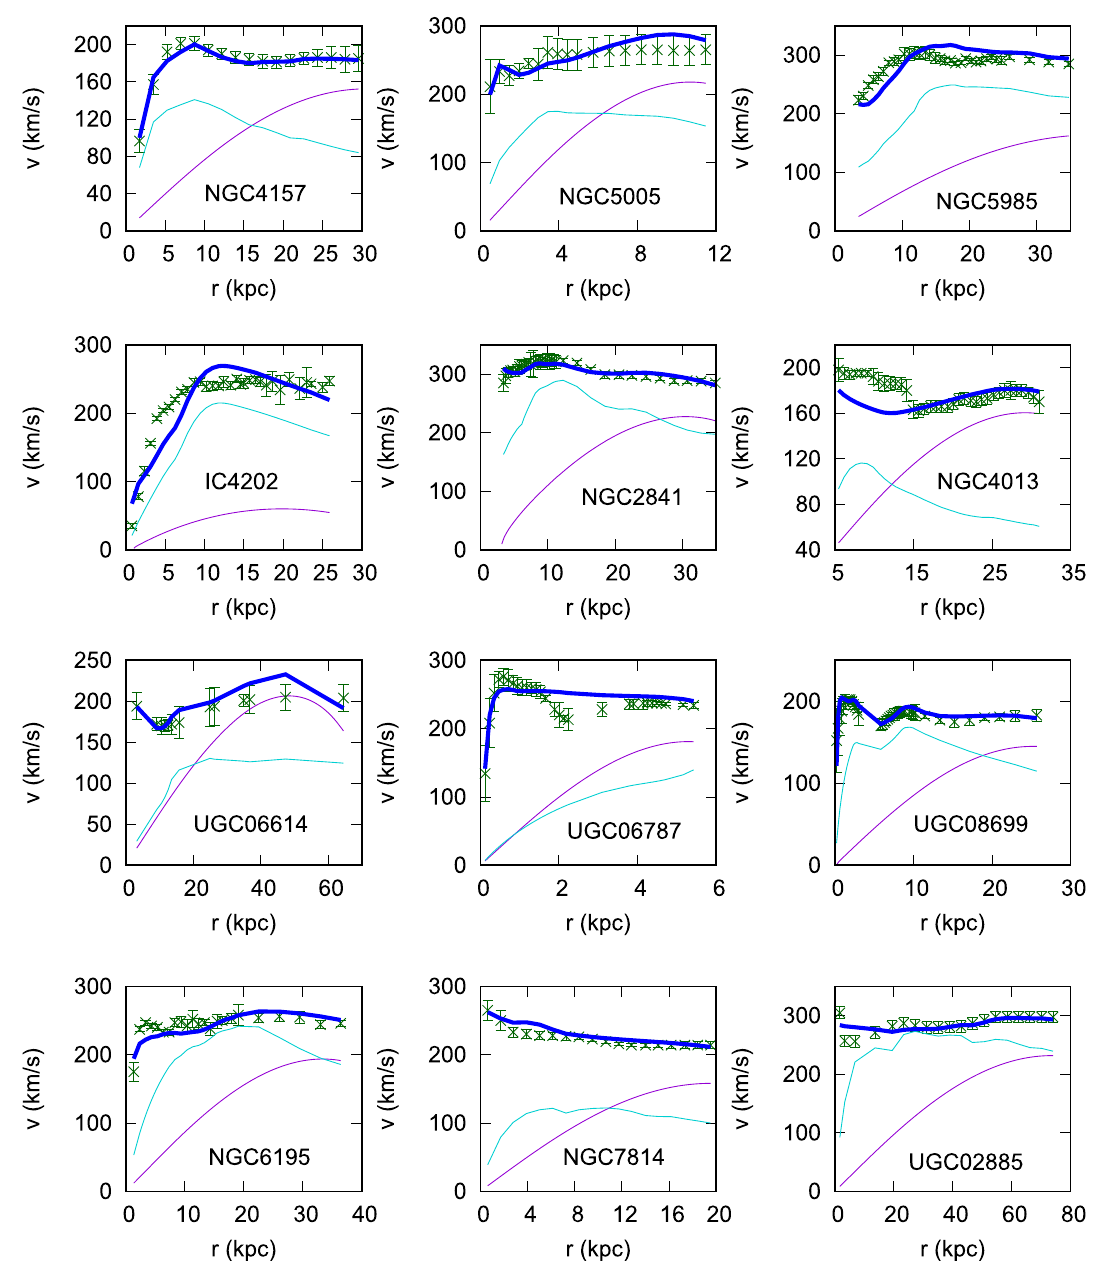
Fig. 6 Comparison of the theoretical predictions for the galactic rotation of the random Bose–Einstein Condensate dark matter model with 12 SPARC galaxies with bulge velocity